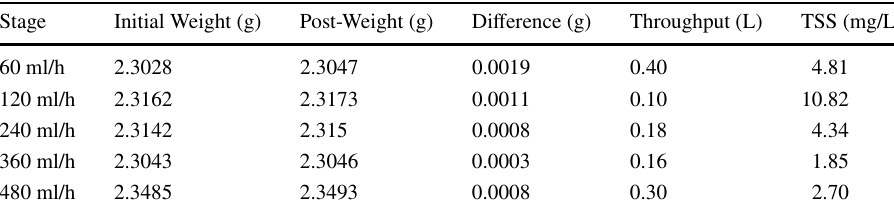
Fig. 8 Differential pressure versus time profile recorded during gas saturation at incre- mental rates and intermediate baseline saturations. Conditions: